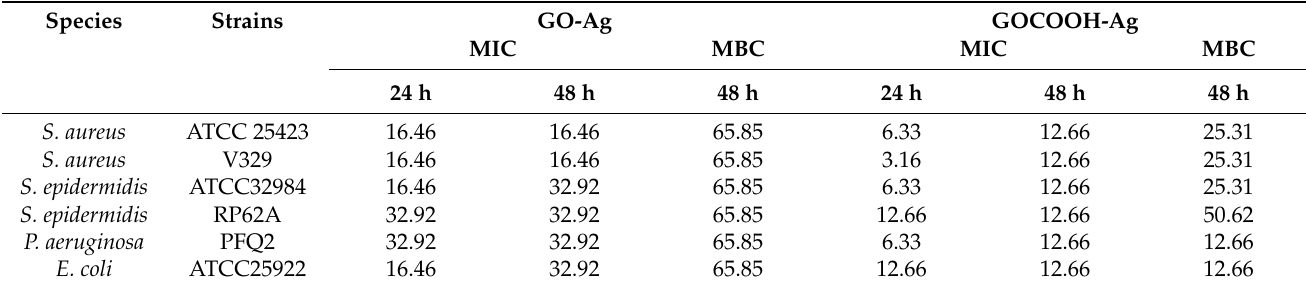
Table 1. MIC and MBC ( µ g/mL) of GO-Ag and GOCOOH-Ag values for all strains